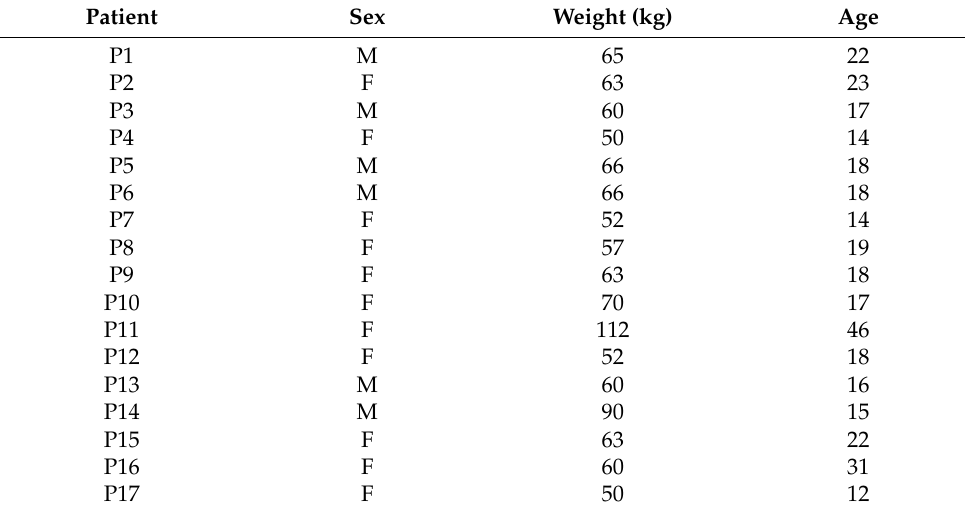
Table 1. Main characteristics of the patients included in this study.